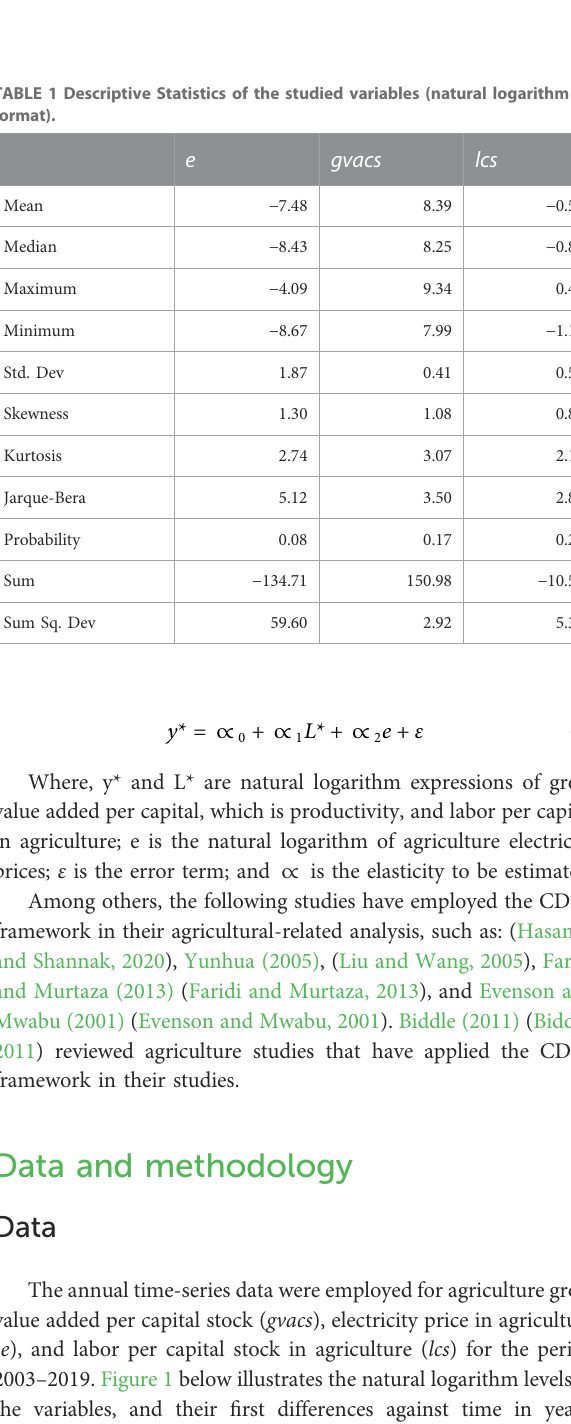
TABLE 1 Descriptive Statistics of the studied variables (natural logarithm